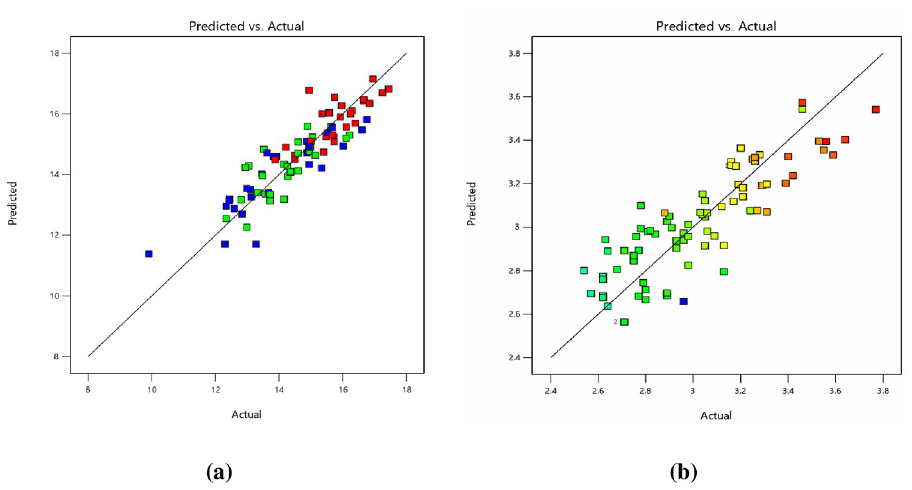
Fig 5. Predicted vs Actual value plot (a) Marshall Stability; (b) Flow Value.